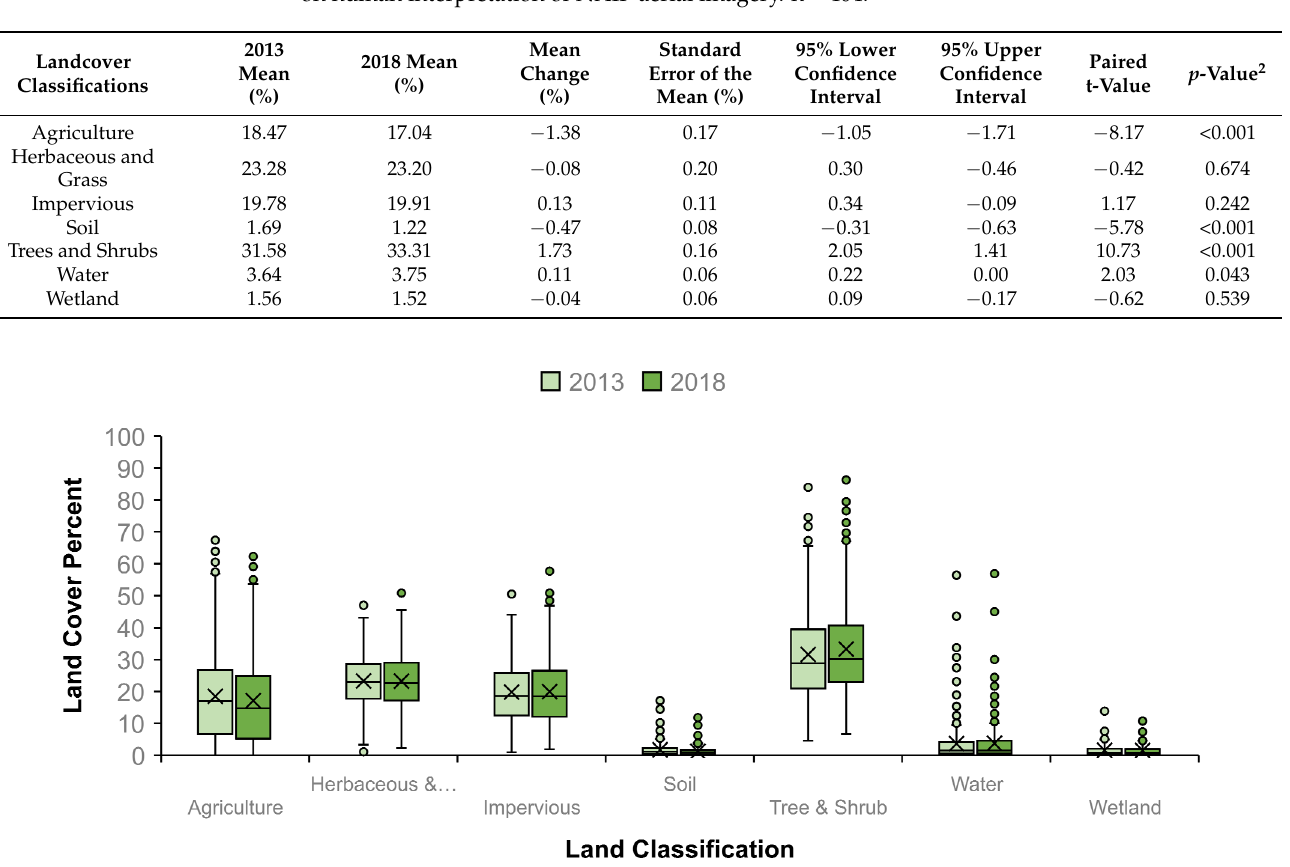
Figure 3. Landcover classification box plot comparison between artificial intelligence and human intelligence in WI, USA (n = 397). All location significantly different ( p < 0.001) except for herbaceous ( p = 0.743). Box plots parts are lower box 1st quartile, line median, X mean, upper box 3rd quartile, line ends are minimum and maximum values, and circles are outliers. Table 3. Landcover classification change between 2013 and 2018 in WI, USA. Percentages are based on human interpretation of NAIP aerial imagery. n = 404.